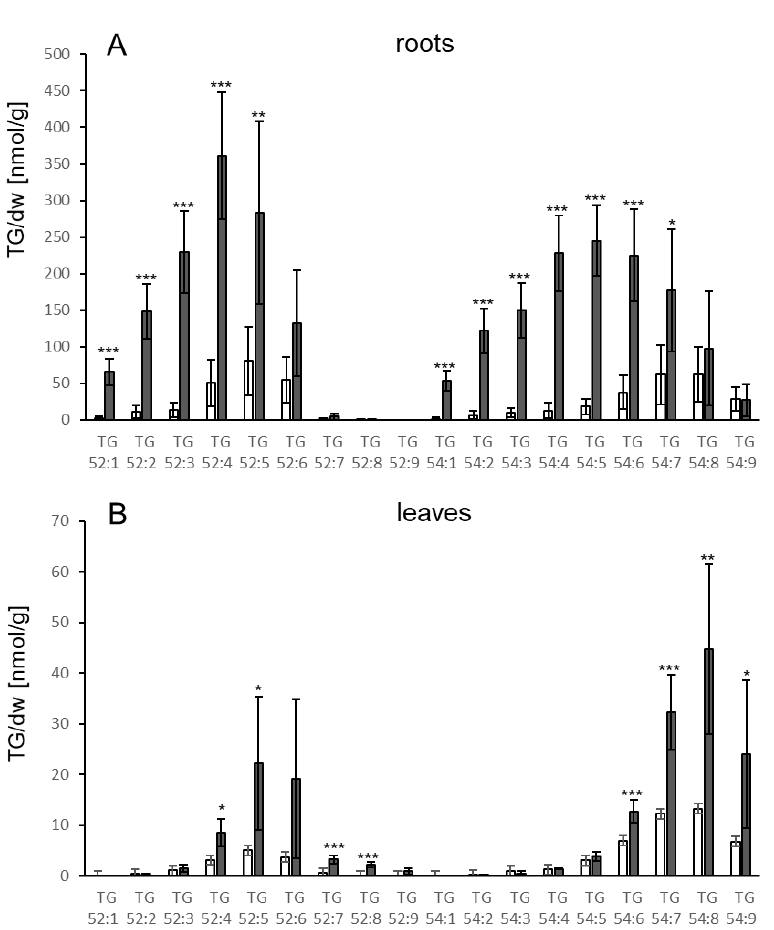
Figure 6. Accumulation of different TG species in ( A ) roots and ( B ) leaves of Col-0 3 d after treatment of roots with 50 µg/mL LPS (dark grey bars) or mock (white bars). TG species are characterized by their total number of acyl carbons and the number of double bonds. TG levels [nmol/g dry weight] shown represent the mean of five biological replicates ± sd. Asterisks indicate significant differences between the LPS treated samples and the corresponding mock treated sample (* p < 0.05; ** p < 0.01; *** p < 0.001).